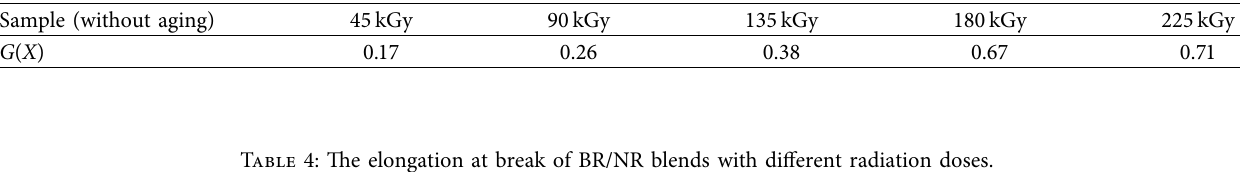
Table 3: The G(X) values of BR/NR blends without aging process.